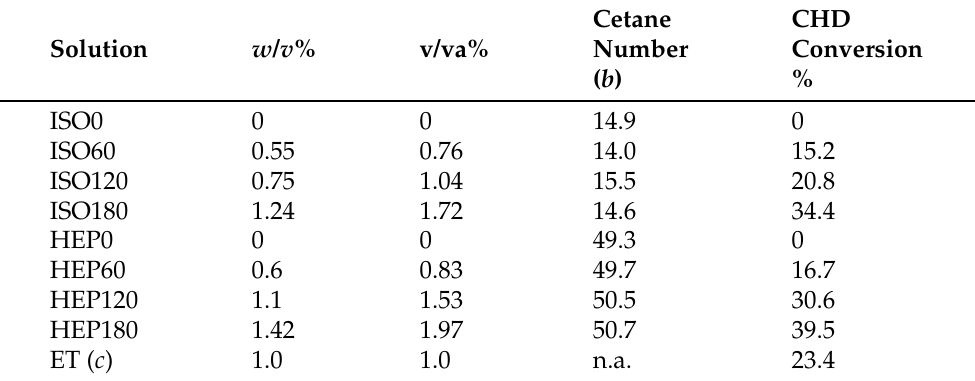
Table 3. Analysis results of the immersion well reactor experiments: hexatriene concentrations in the